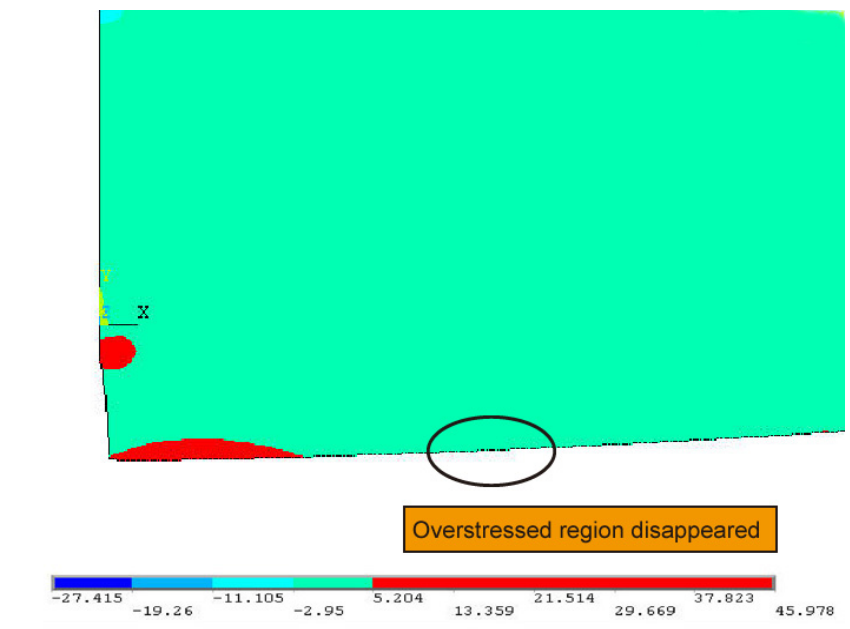
Figure 18. The distribution for the maximum principle stresses in concrete material at the end of the CFRP with a length of 0.35 m.